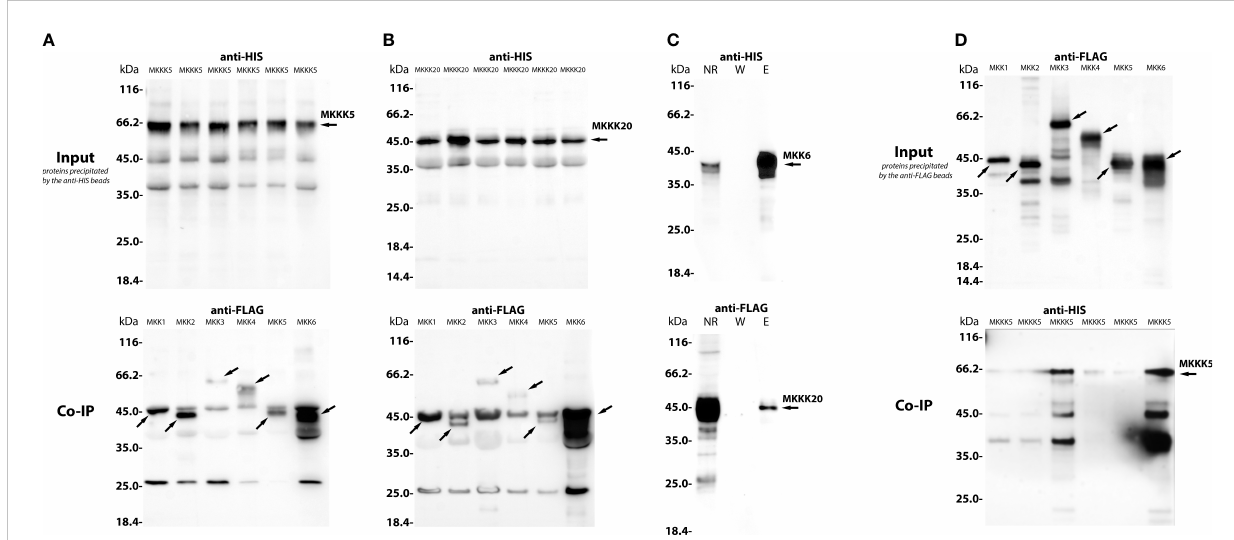
FIGURE 7 The co-immunoprecipitation of PsMAPKKK5, PsMAPKKK20 and PsMAPKK1, PsMAPKK2, PsMAPKK3, PsMAPKK4, PsMAPKK5, PsMAPKK6 from P. sativum cv. Finale. A heterologous protein expression was carried out in Escherichia coli C41, allowing high levels of expression of all proteins of interest fused to 6xHIS or 3xFLAG tag (A – D) . The lysates containing HIS-tagged and FLAG-tagged proteins were co-incubated with beads for 1 – 1.5 h on ice and then were loaded onto a µMACS column placed in the magnetic stand. After washing 3 - 4 times, the elution was done with a denaturing elution buffer followed by Western-blot analysis. In panels (A, B) , the HIS-tagged proteins (PsMAPKKK5, PsMAPKKK20) and